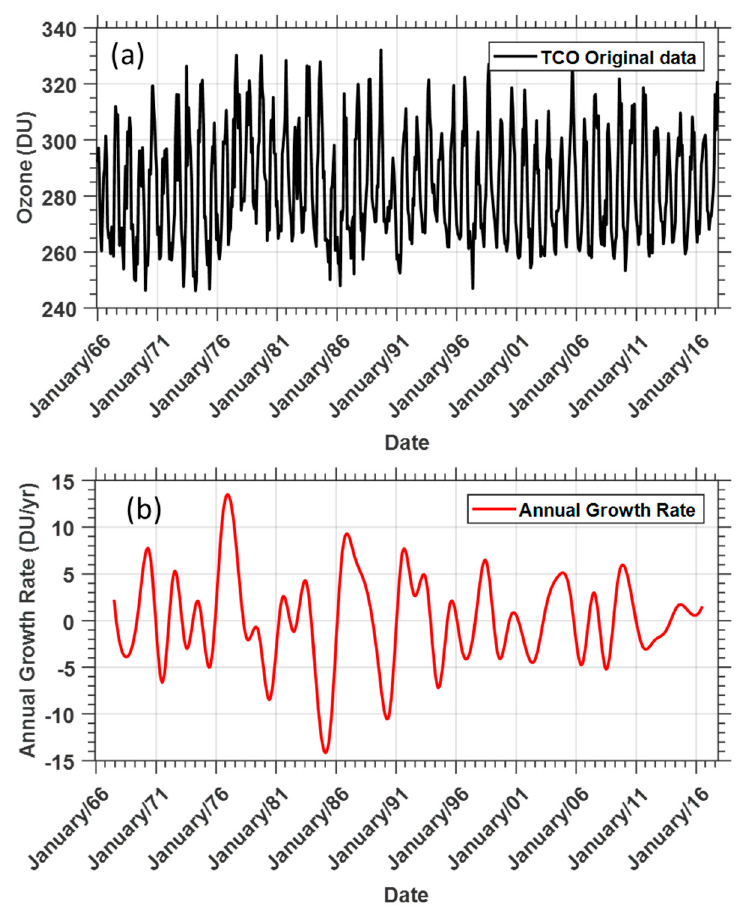
Figure 4. Total columns of ozone (TCO) time series at the Observatorio Central Buenos Aires (OCBA) ( a ) and its corresponding annual mean growth rate ( b ).